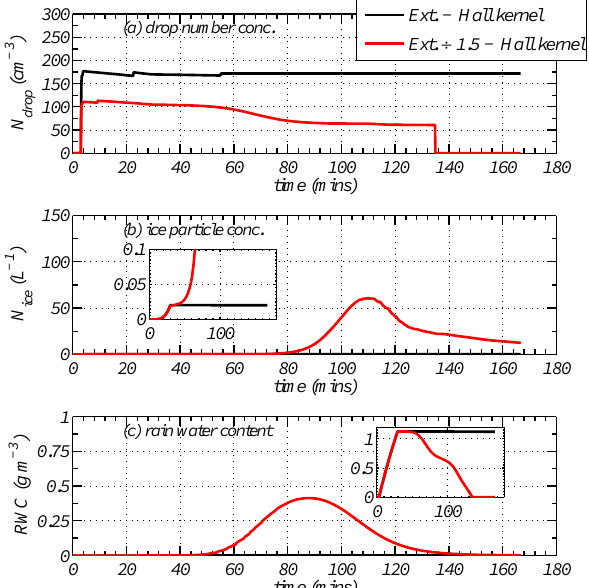
Fig. 13. As Fig. 12, except black lines correspond to a run with the Hall (1980) collision kernel and the red lines correspond to a run using a turbulence enhanced collision kernel after Pinsky et al. (1999). Note that enhancement of the collision efficiency of drops by turbulence significantly enhances the collision-coalescence pro- cess, which has a marked effect on the Hallett-Mossop